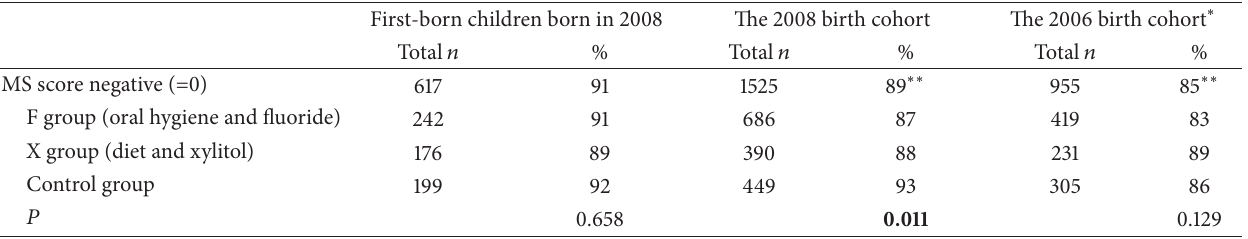
Table 1: First-born children, born in 2008, in comparison with the 2008 and 2006 birth cohorts; percentages of negative MS scores in 24– 36-month old by